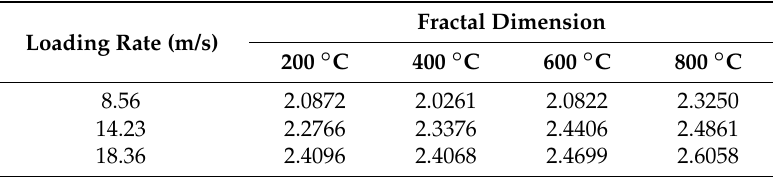
Table 2. Fractal Dimension of Crushing